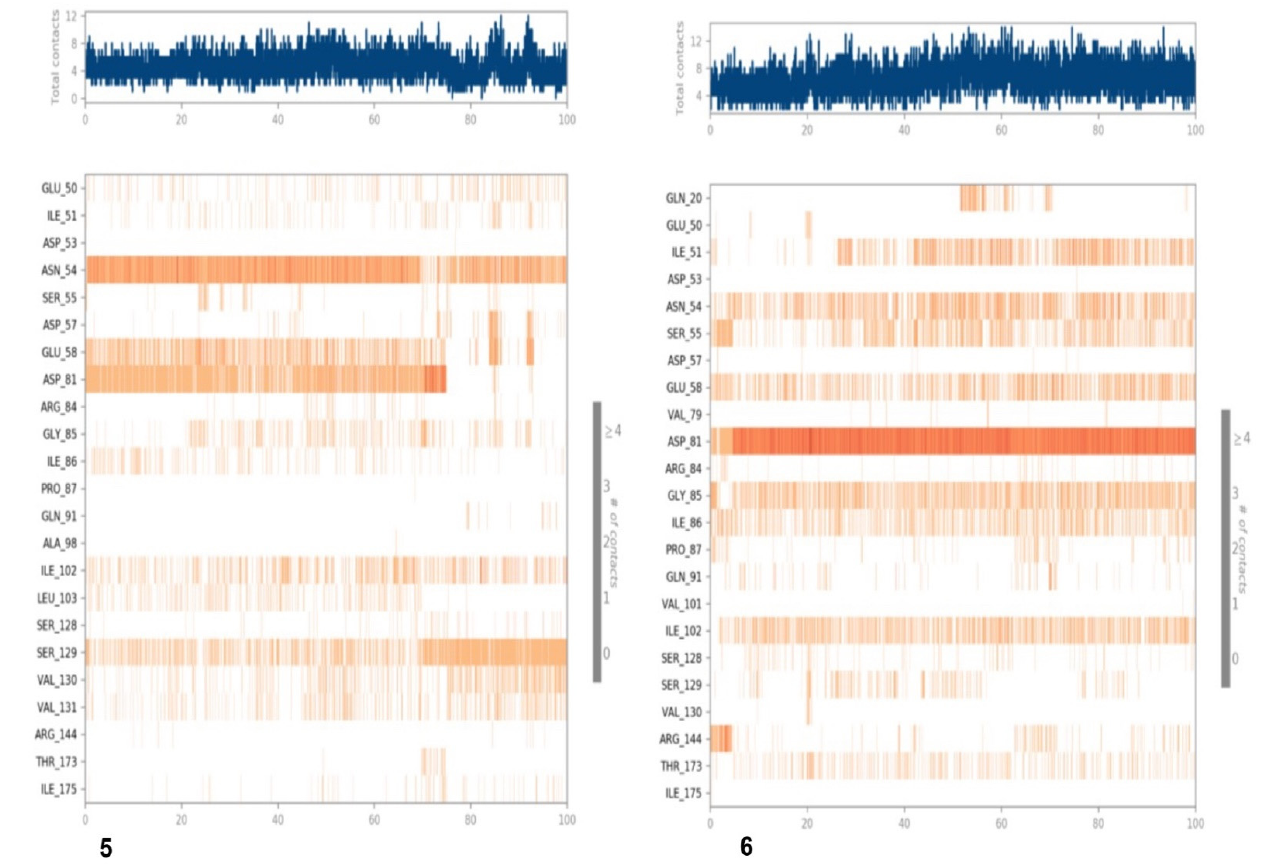
Figure 13. Timeline representation of the interaction and contacts.Top panel shows specific contact of ligand and protein during 100 ns simulation of compounds 5 and 6 with 2HCK.